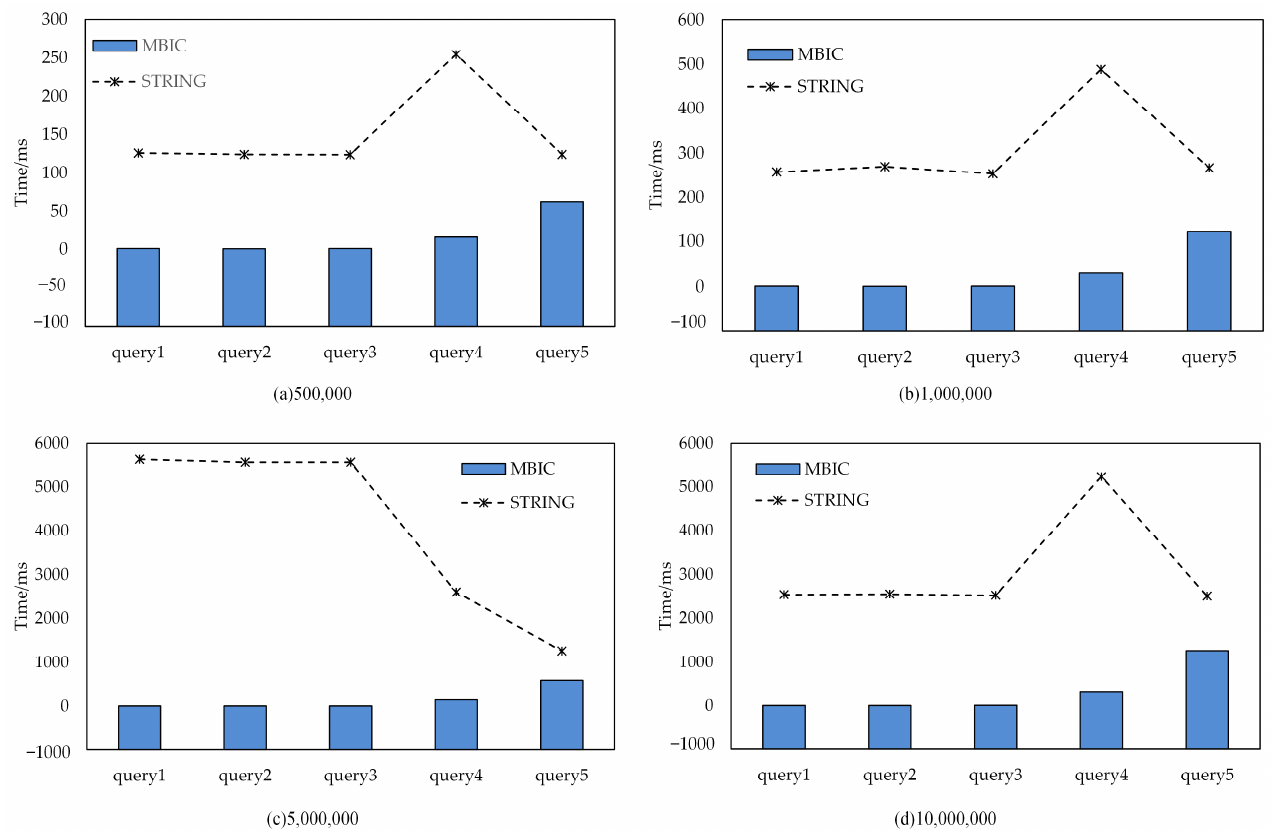
Figure 11. The query time of the two coding methods under different band data.